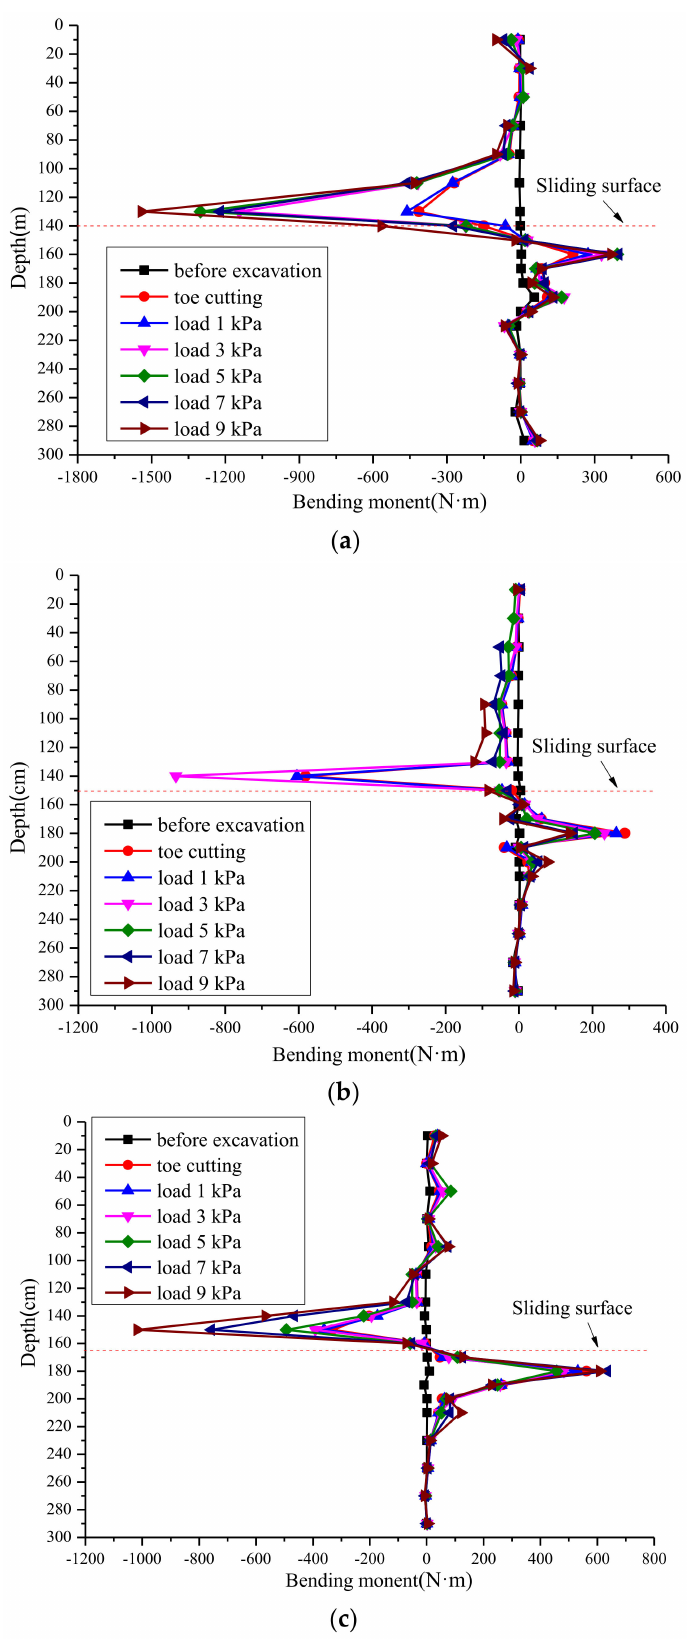
Figure 19. Bending moment of micro-piles: ( a ) bending moment of pile no. 4; ( b ) bending moment of pile no. 3; ( c ) bending moment of pile no.